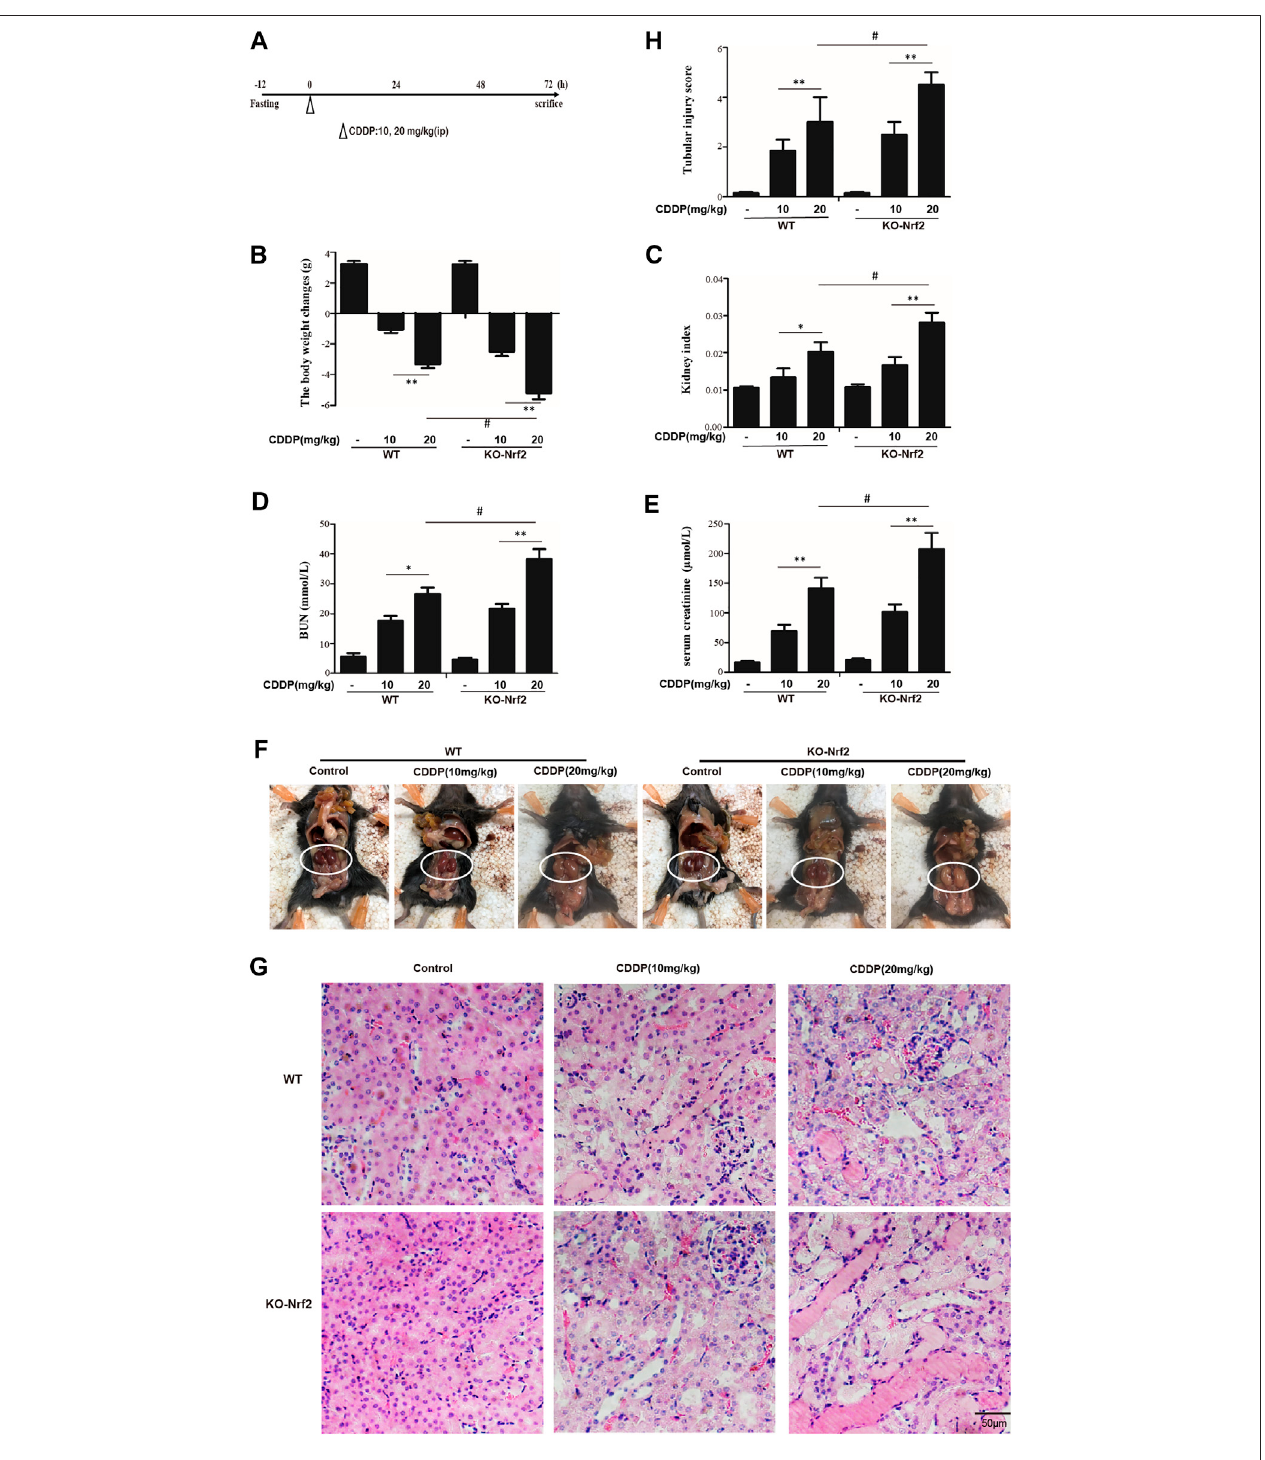
FIGURE 1 | Nrf2 − / − mice are more susceptible to CDDP-induced AKI. (A) An acute kidney injury model was induced 3 days after i.p. injection of CDDP (10, 20 mg/kg). WT mice and Nrf2 knockout (KO) mice treated with CDDP (10, 20 mg/kg) are shown. (B) Body weight and (C) Kidney/body weight ratio. (D,E) BUN and serum creatinine were measured. (F) macroscopic kidney and (G) hematoxylin and eosin (H&E). (H) Tubular injury scores for kidney damage. * p < 0.05, ** p < 0.01.